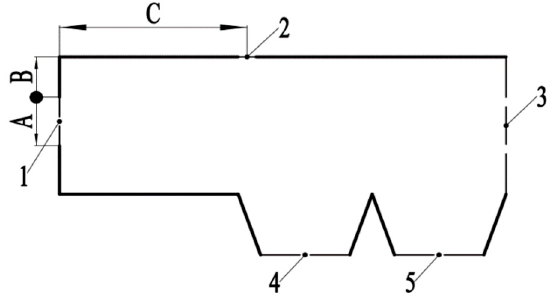
Figure 2. Calculation model: A—depth of section; B—vertical distance; C—horizontal distance; 1—inlet (air flow); 2—inlet (materials); 3—outlet (air flow); 4—outlet 1; 5—outlet 2.